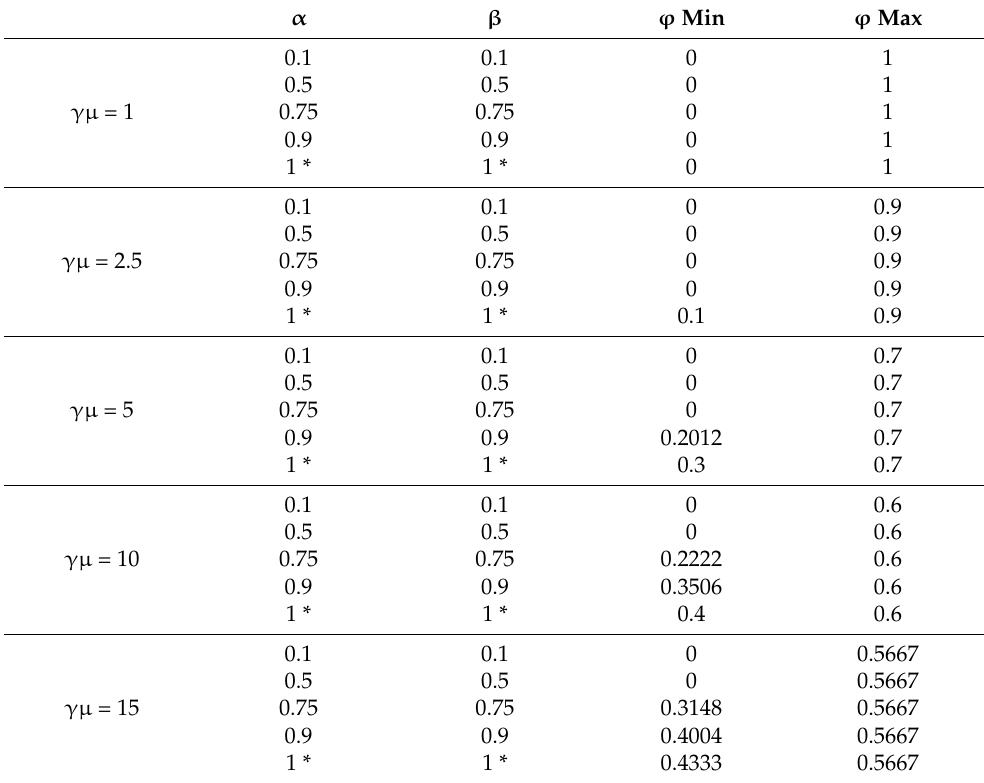
Table 1. Limits of the stability region in terms of ϕ for selected values of γµ , α and β in the case of linear link cost functions.